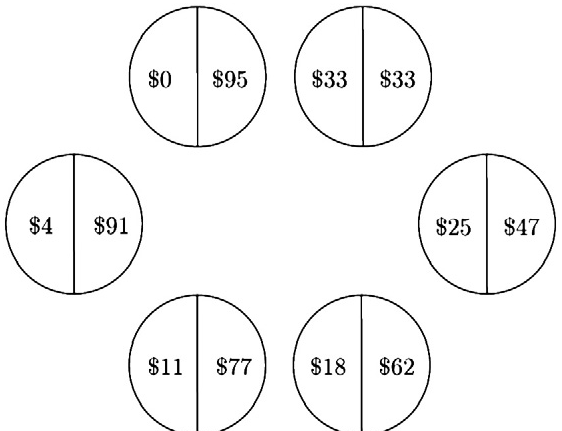
Figure A1. Lottery choices in the risk game. The game is based on [46]. Values are in 2014 BRL. This game intends to capture baseline attitudes towards risk. Subjects choose one of six lotteries. As one moves clock-wise around the ring, the lotteries increase in risk and expected payoff except for the last lottery, which has the same expected payoff as the fifth but has higher variance. Within each lottery, the odds of a high payment are the same as the odds of a low payment (50% probability). To determine payouts for the task, participants choose one lottery and a computer randomly chooses an outcome of that